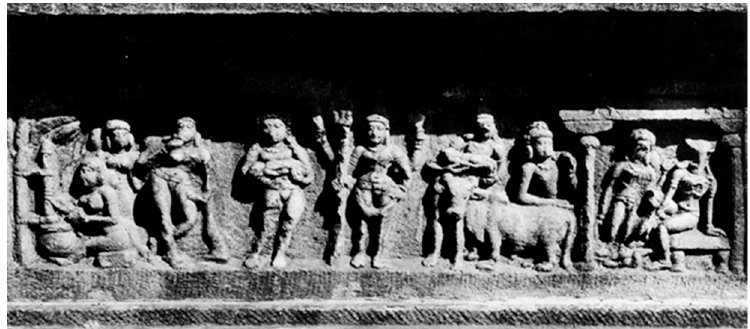
of the Upper Ś iv ā laya, B ā d ā m ī , Karnataka.